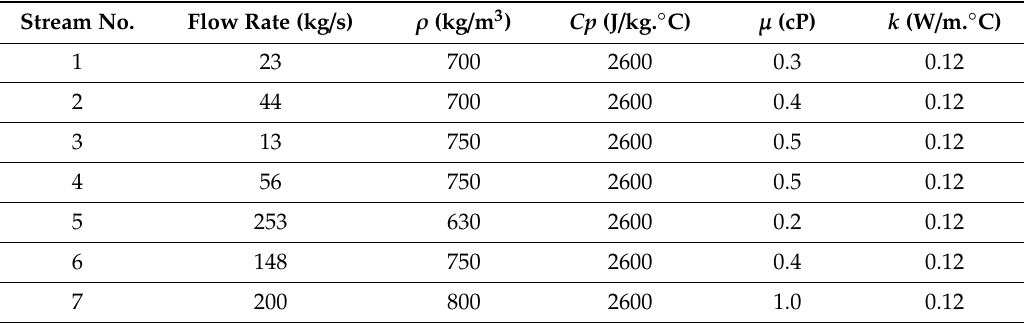
Table A1. Flowrates and physical properties for crude oil pre-heat train. Stream No.